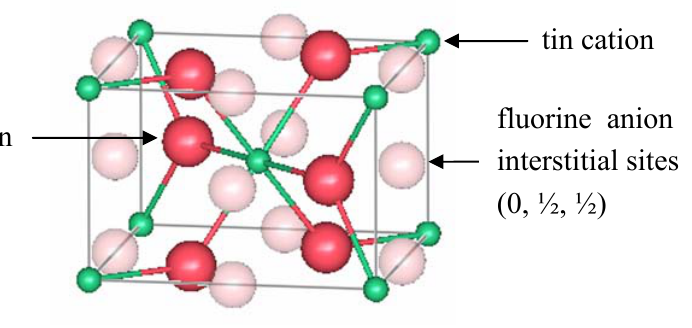
Figure 5. A unit cell of rutile SnO Canestrato et al.